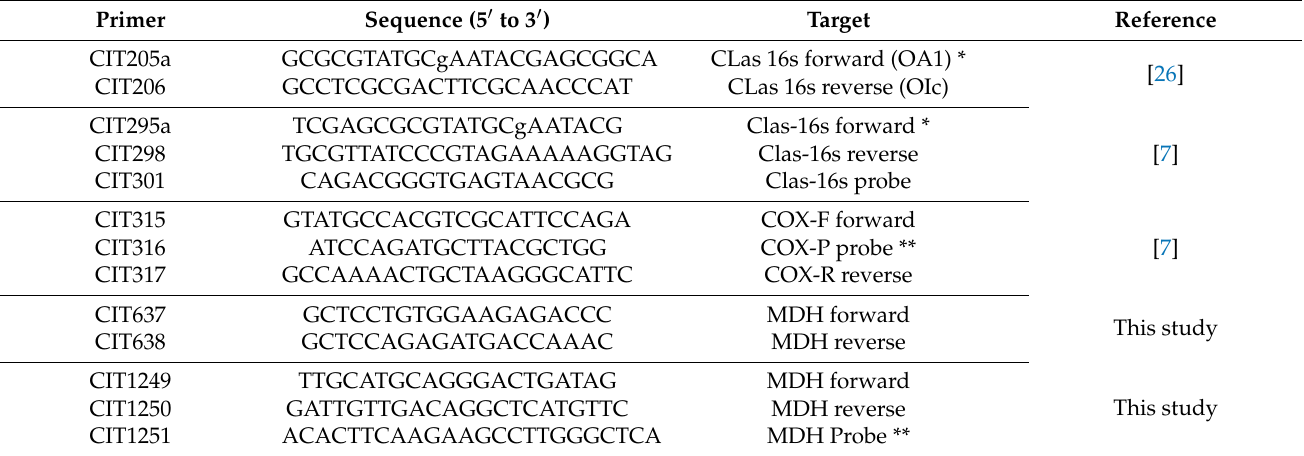
Table 1. Primers used for conventional, qPCR, and digital PCR detection of various targets. Primers cit637 and cit638 were used for conventional PCR to amplify 900 bp fragments of MDH gene. Other primers and probes were used for qPCR and ddPCR